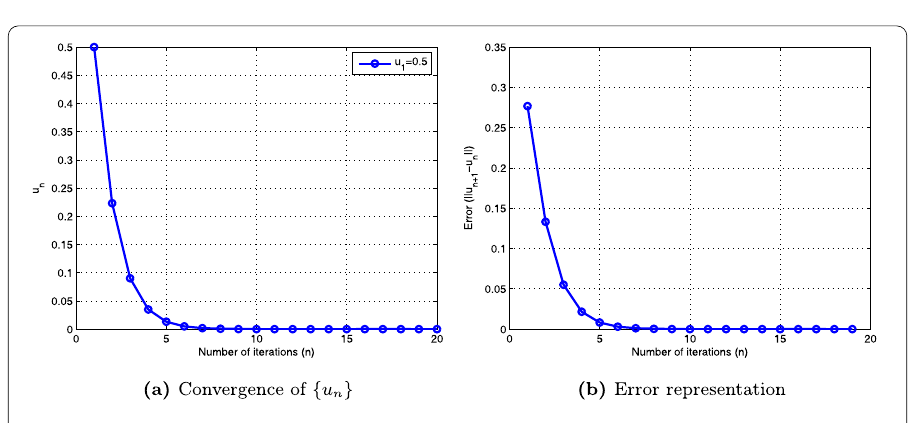
Figure 2 Example 6.1, Case II with u 1 =